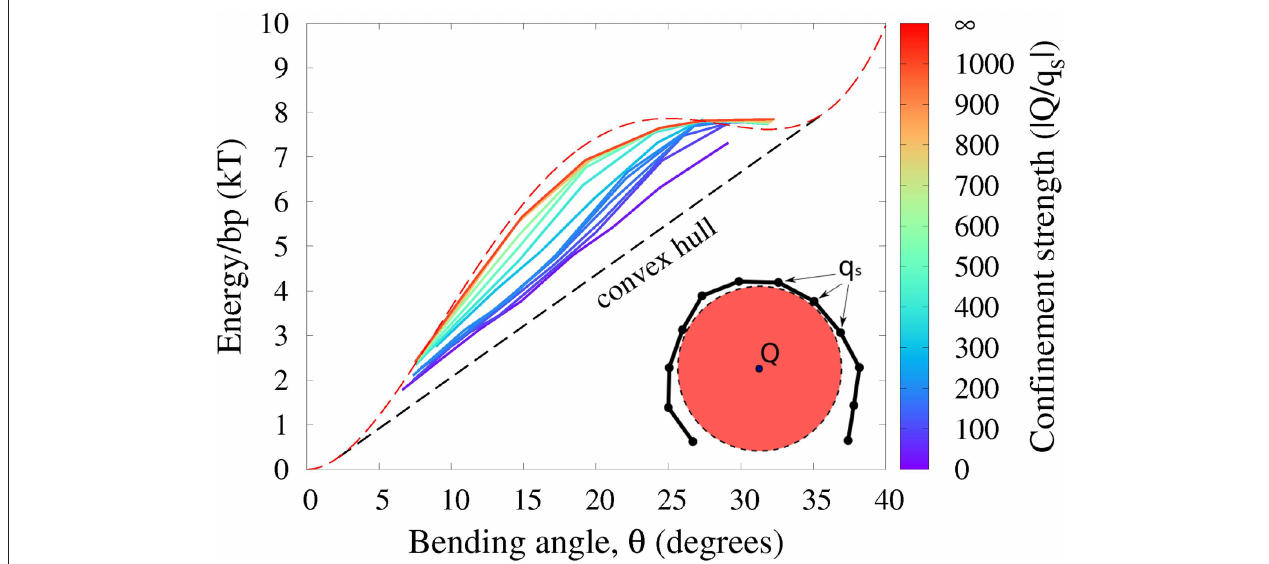
FIGURE 8 | Polymer bending in a “protein-DNA complex” model with variable strength of polymer confinement and curvature (see “Methods”). The red circle represents the cylindrical charged core of the “protein” to which the oppositely charged “DNA” (black chain) is attracted. Under weak confinement, the system follows the convex hull of the effective E ( θ ), while approaching E ( θ ) (red dashed line) itself for strong confinement. Shown is the average energy per bead against the average bending angle θ , at different confinement strengths governed by the ratio | Q / q s | of the confining charge Q to the opposite charge q s of the confined polymer. The intrinsic bending of the polymer is described by (experimental) E ( θ ) from Figure 4